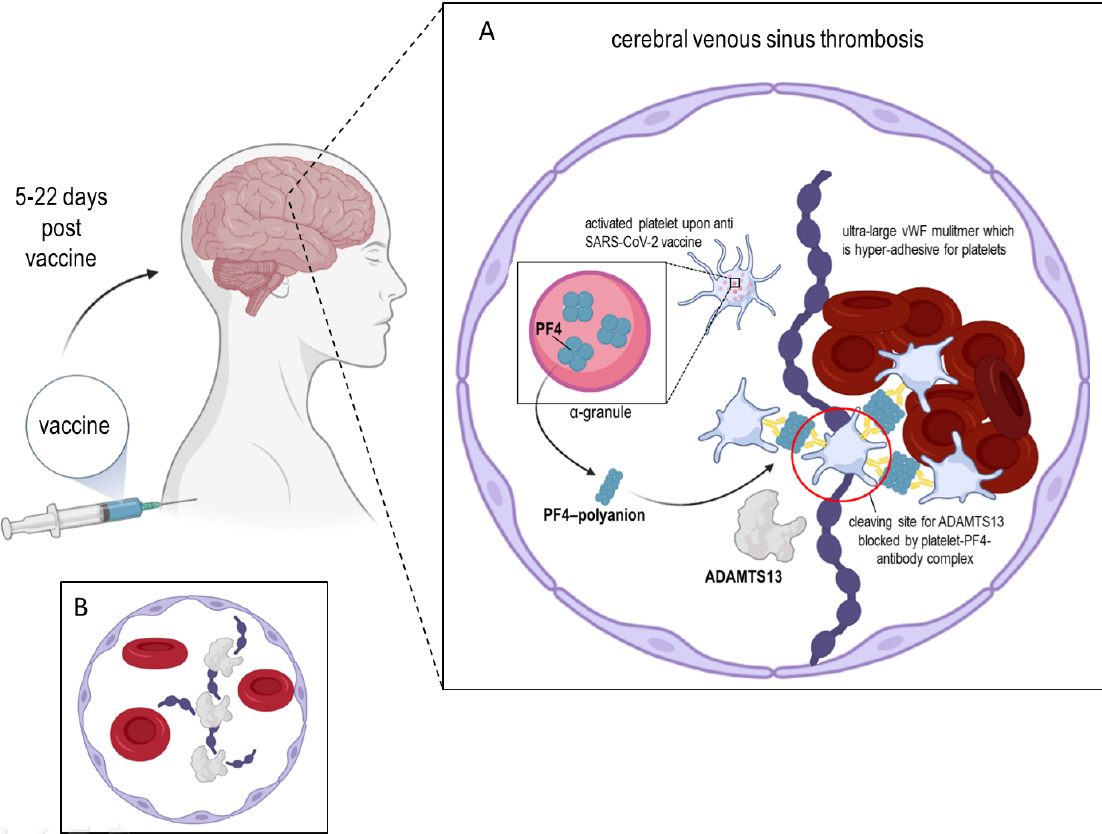
Figure 2. Scheme showing the possible link between ADAMTS13 and the vaccine-induced immune thrombotic thrombocytopenia. ( A ): In some rare cases, about 5–22 days post-vaccination against SARS-CoV-2 (ChAdOx1 nCoV-19), acquired autoantibodies against PF4 are forming complexes with ultra-large VWF multimers that are hyper-adhesive to platelets and lead to an inhibition of ADAMTS13 activity, which is then unable to regulate the multimeric size of the VWF. Here, we presented how the autoantibodies against PF4 could mimic heparin by binding to PF4 and forming clusters (red circle). In consequence, these complexes with platelet factor PF4 are promoting the persistence of endothelium-anchored ultra-large VWF strings which are capable of recruiting circulating platelets and causing uncontrolled thrombosis in terminal capillaries, by promoting aggregation, platelet consumption, and micro-thrombi formation within the capillary network. Thrombocytopenia appears to result from pronounced apoptosis and clearance of antibody-coated platelets additionally to consumption during the coagulation process. ( B ): Physiological functioning of ADAMTS13 which cleaves VWF strings to smaller, less adhesive multimers.